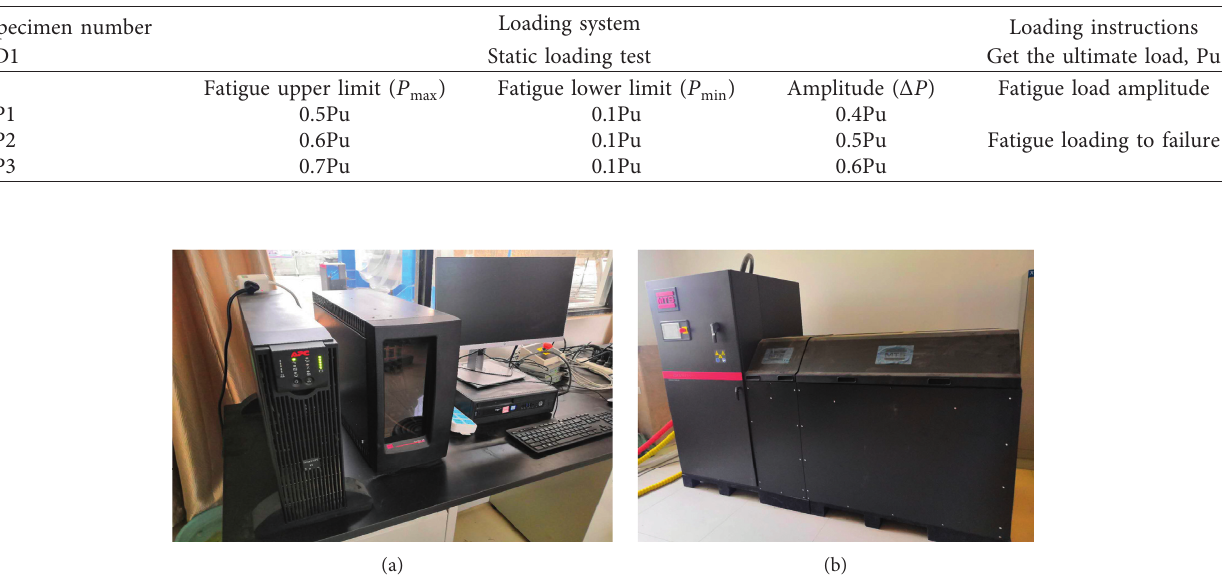
Figure 3: Test scheme and layout of measuring points (unit: mm). Table 3: Test conditions.